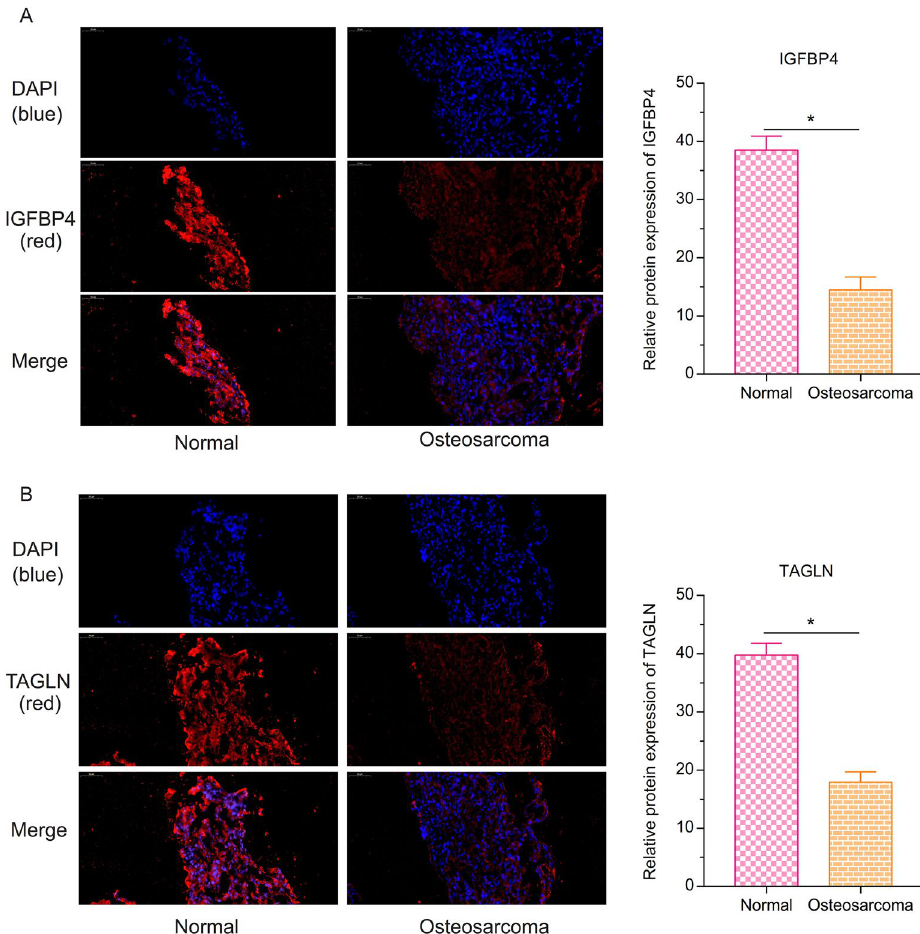
Figure 10. The verification of protein expression of IGFBP4 and TAGLN by the immunofluorescence assay. Protein expression of ( A ) IGFBP4 and ( B ) TAGLN in the osteosarcoma was lower than the normal. (*P <